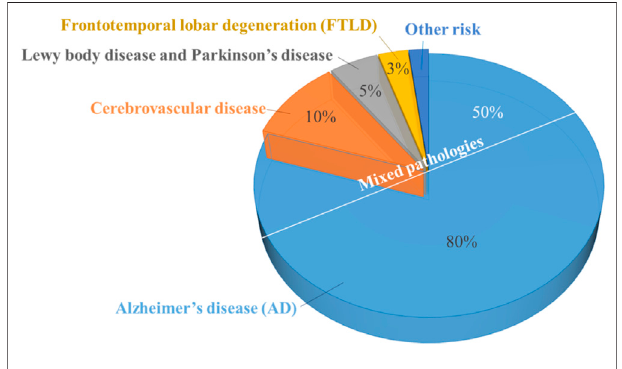
FIGURE 1 | Common disease causes of dementia percentage.